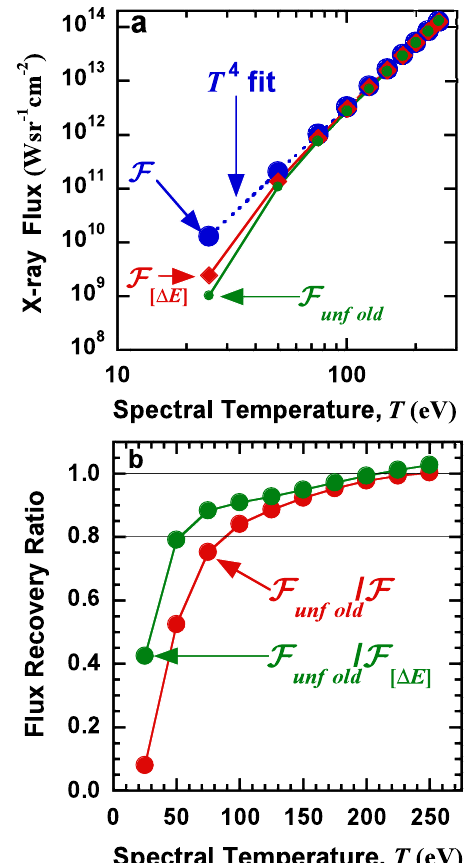
on the response functions and unfold